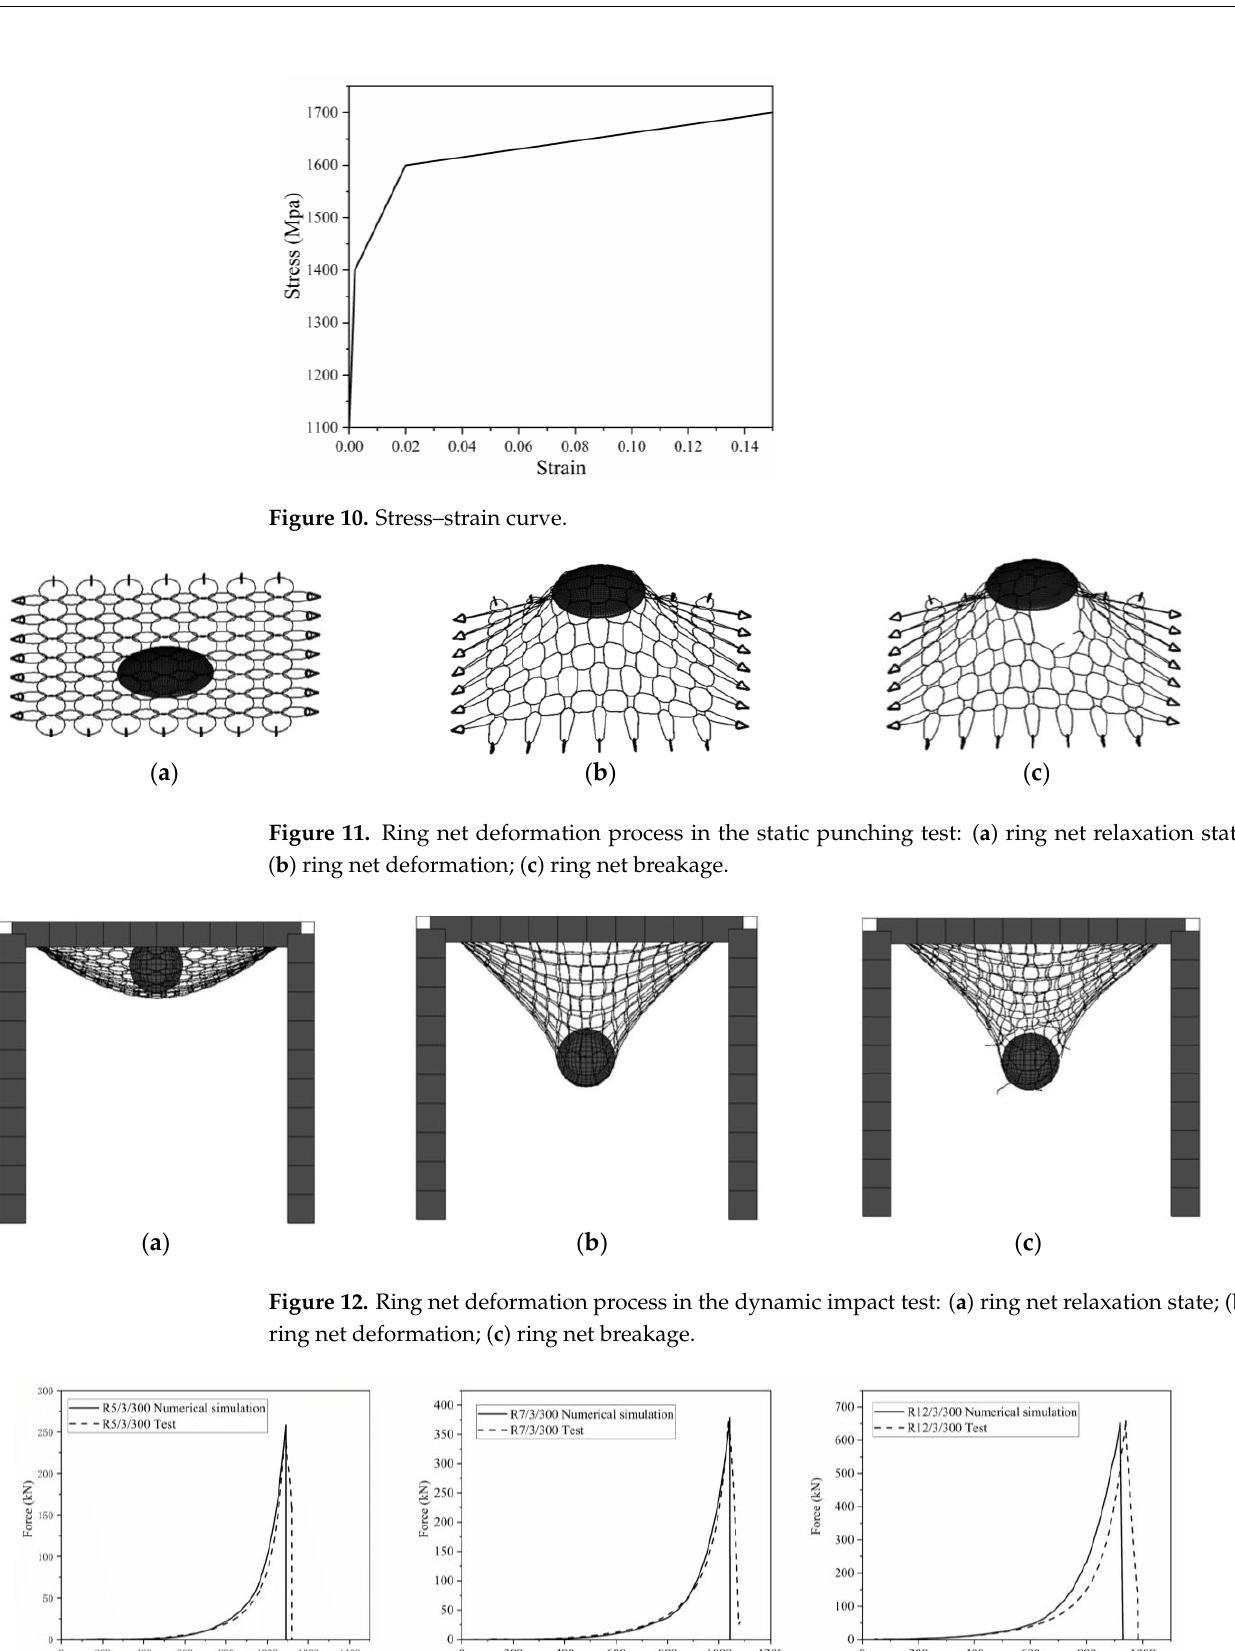
Figure 14. Comparison of experimental and numerical simulation results in the dynamic shock test. 5.2. Analysis of Rockfall Impact Velocity The parameters in the static punching and dynamic impact models were as follows: net size: 3.9 × 3.9 m, net specification: R7/3/300, diameter of the punching head: 0.8 m, and diameter of the falling rock: 0.8 m. The rockfall impact velocities were 17 m/s, 20 m/s, 25 m/s, and 35 m/s. The breaking force, breaking displacement, and net energy consumption of the ring net under different impact velocities are shown in Figure 15. Figure 15. Equivalent coefficients at different rockfall impact velocities. As shown in Figure 15, with an increase in the impact velocity, k F decreased linearly from 1.082 to 0.792, a decrease of 26.8%, k D decreased from 1.024 to 0.948, a decrease of 26.8%, and k E decreased linearly from 1.246 to 1.002, a decrease of 19.6%. As the contact time between the tested rock and ring net was shorter at higher rather than lower velocity